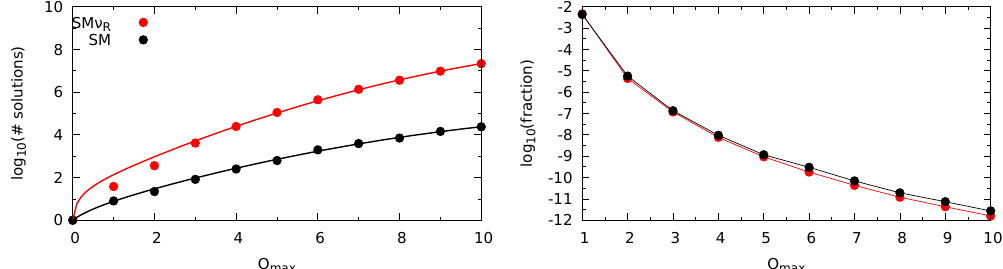
Figure 2 . Left : the total number of inequivalent anomaly-free solutions with a given Q max , together with the functions 1+ a exp( bQ max + cQ 2 ) (cid:0) a which are (cid:12)t the growth of the number of solutions: max a = 22 : 5, b = 2 : 0, c = (cid:0) 0 : 062 for the SM (cid:23) R and a = 2 : 50, b = 1 : 34, c = (cid:0) 0 : 043 for the SM. Right